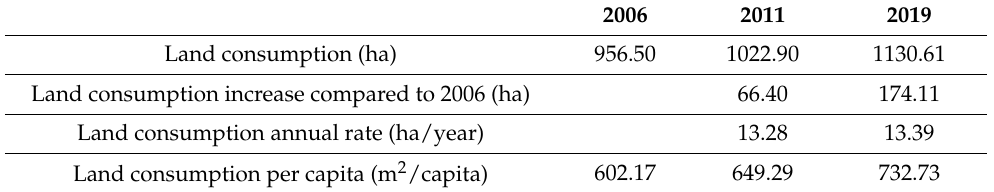
Table 2. The total land consumption (ha) in 2006, 2011, and 2019, the land consumption increase (ha) in 2011 and in 2019 compared to 2006, the land consumption annual rate in 2011 and in 2019 compared to 2011, and the land consumption per capita (m 2 /capita) in 2006, 2011, and 2019.